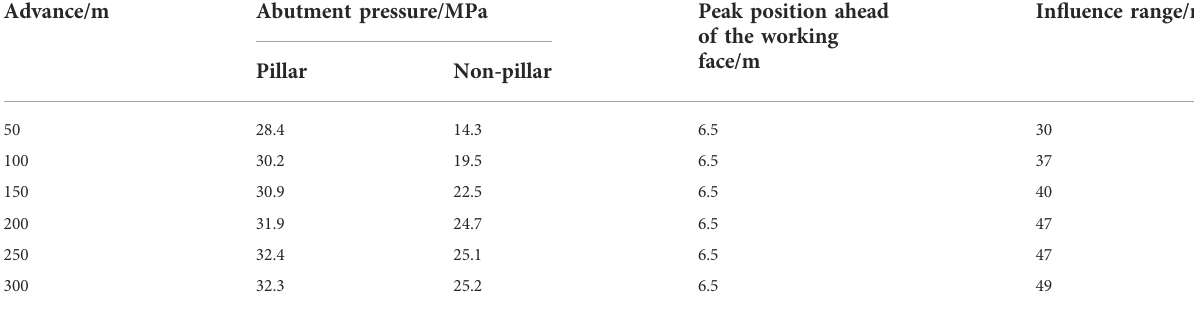
TABLE 2 Statistics of the abutment pressure of the working face.